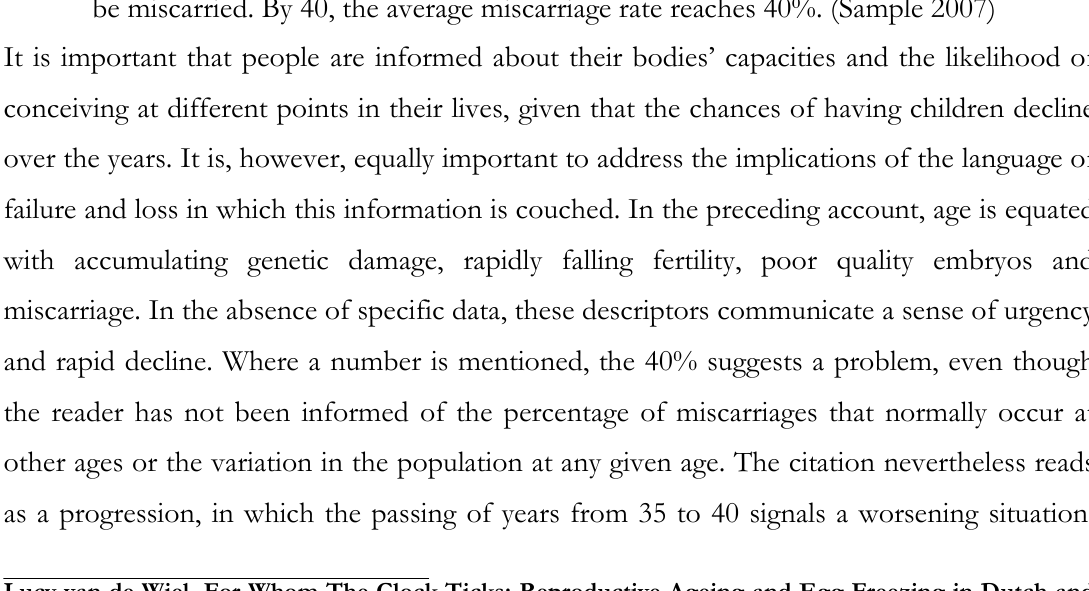
Lucy van de Wiel, For Whom The Clock Ticks: Reproductive Ageing and Egg Freezing in Dutch and British News